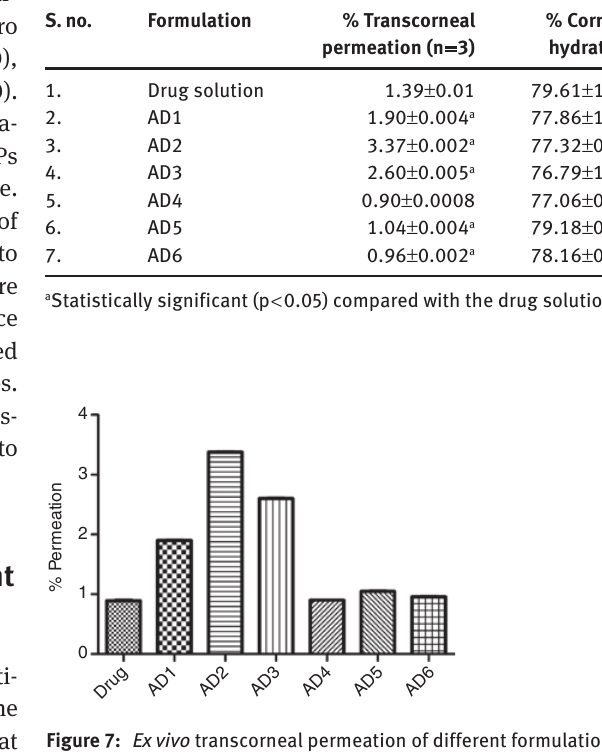
Figure 7: Ex vivo transcorneal permeation of different